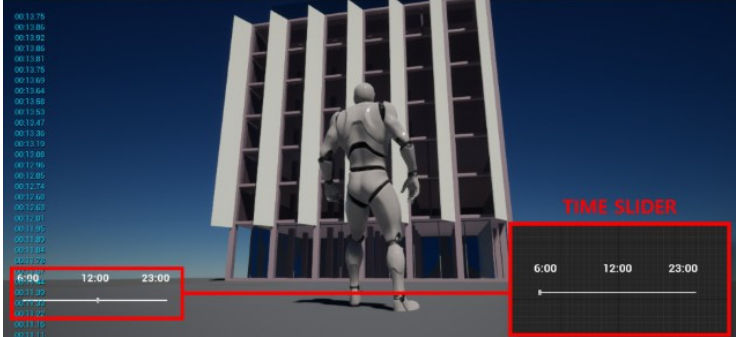
Figure 17. Interactive Motion and Time Slider in the Virtual Environment.